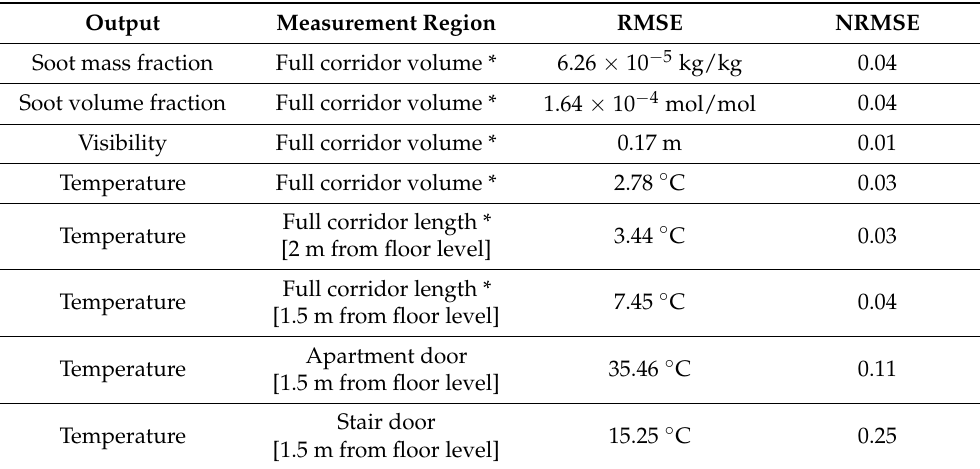
Table 10. RMSE and NRMSE between the established and compressed timeline outputs for the firefighting phase.